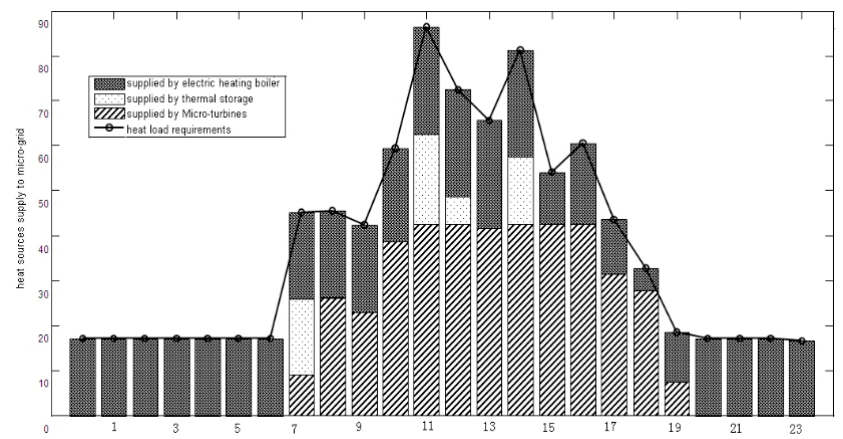
Figure 18. Composition of the heat energy supplies.